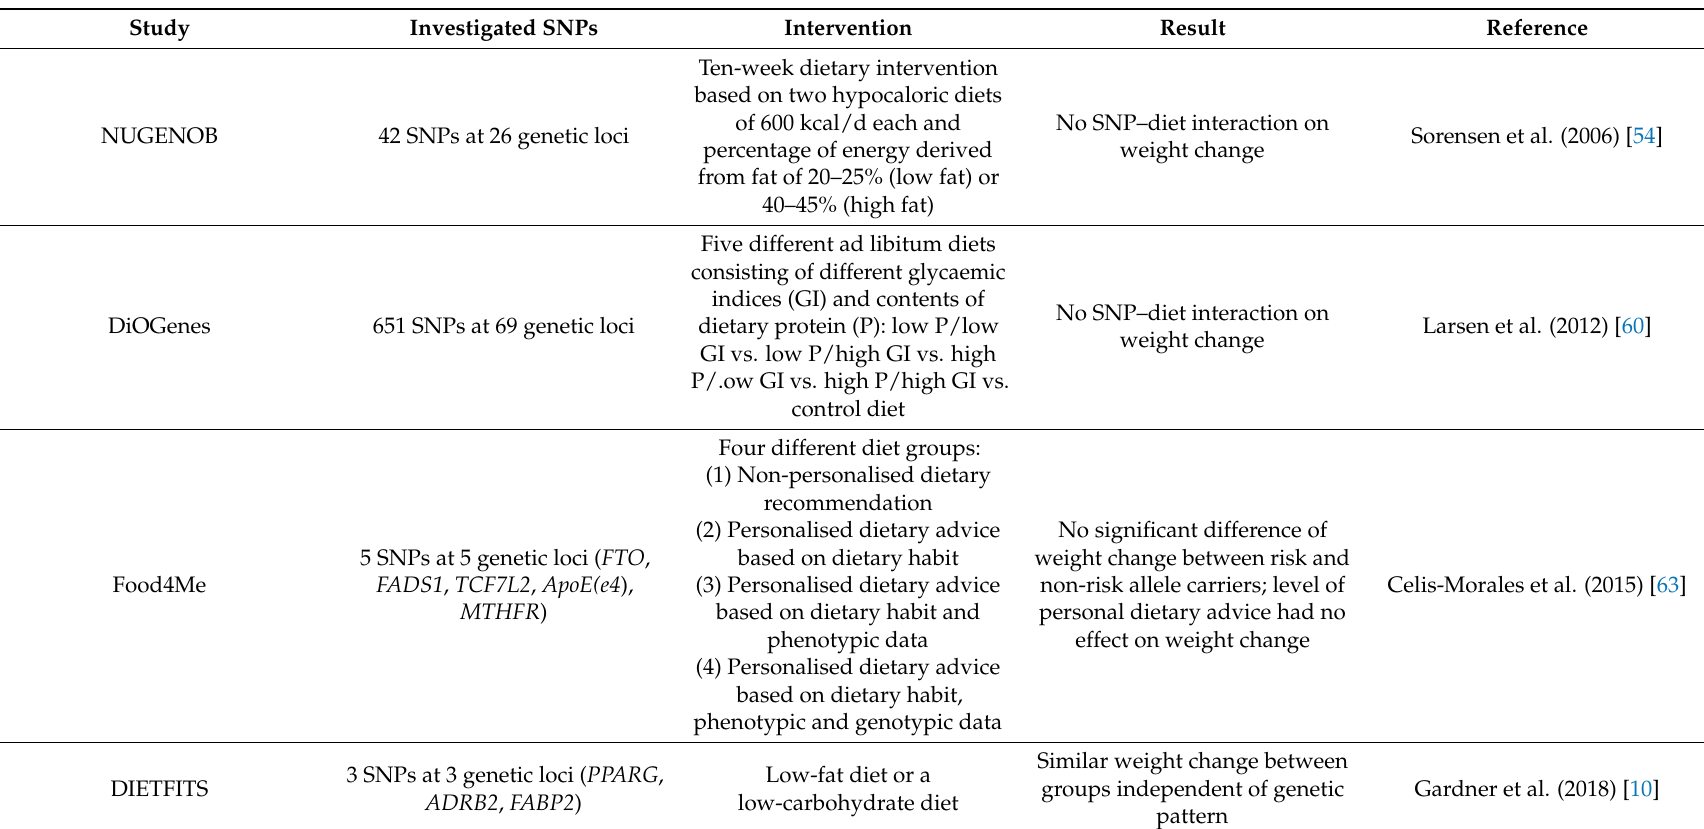
Table 1. Examples of studies investigating associations between genetic variants, dietary intake, and weight